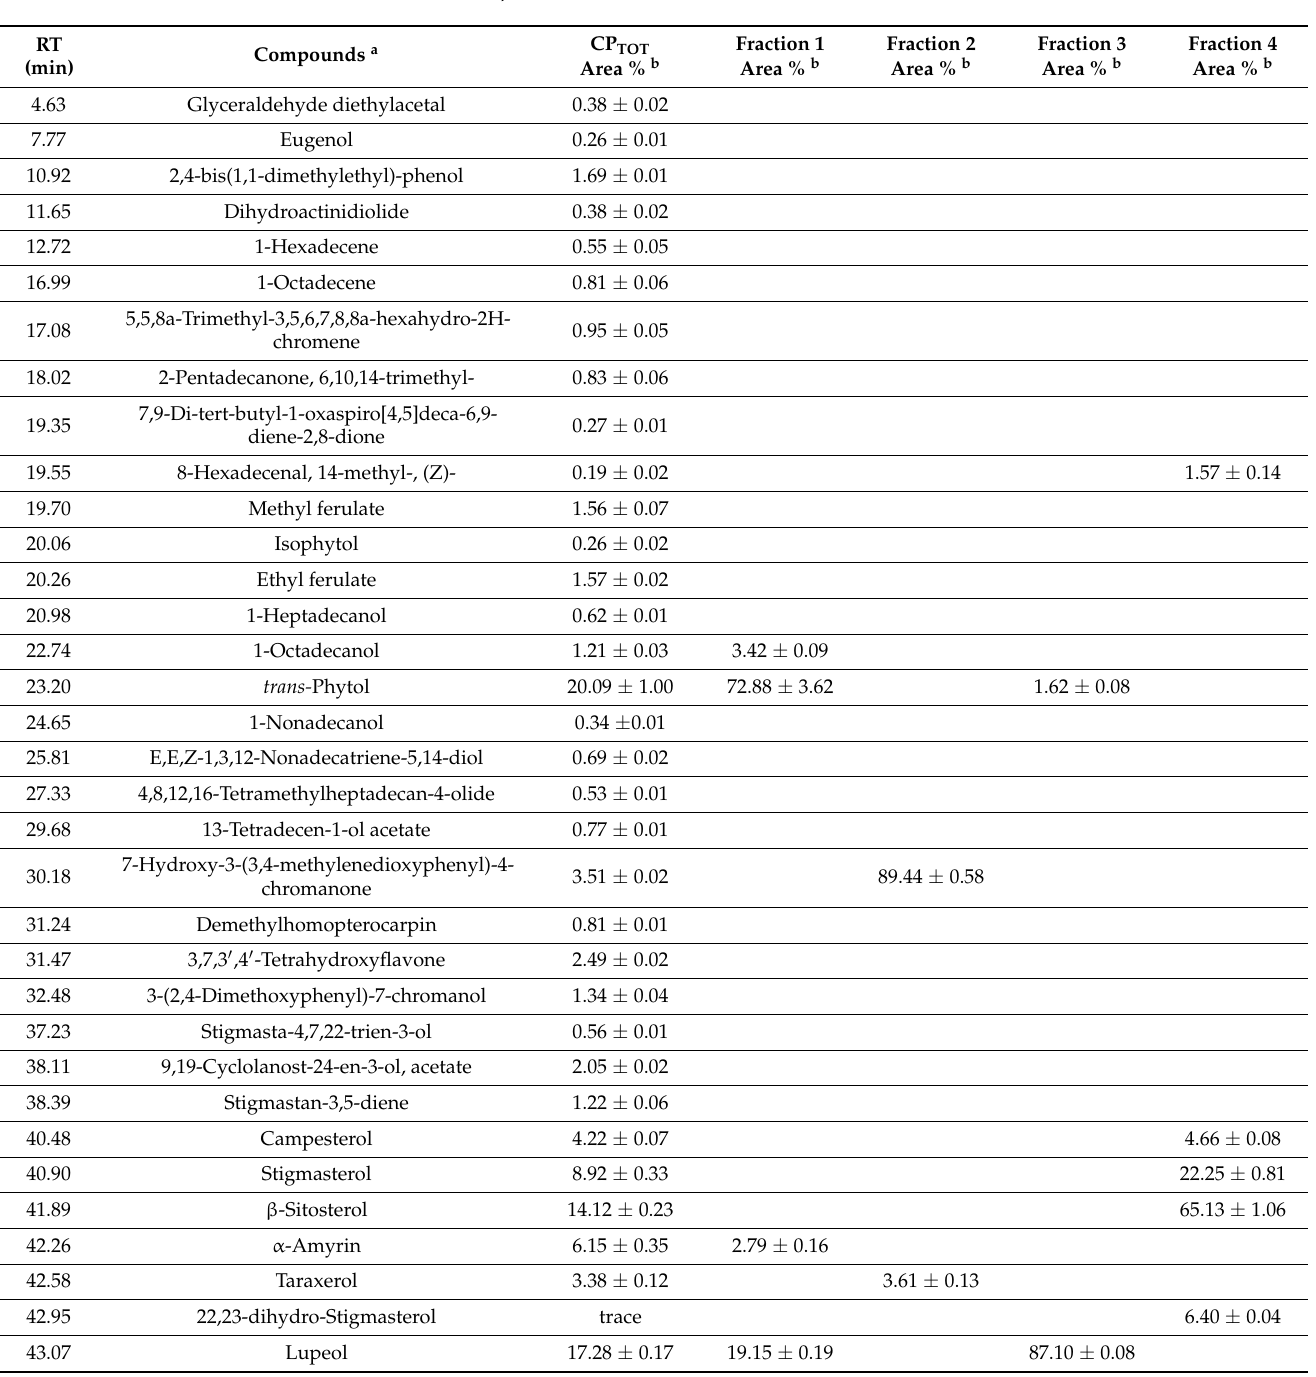
Table 1. Chemical characterization of the total extract (CP TOT ) and of the four fractions obtained from Convolvulus pluricaulis